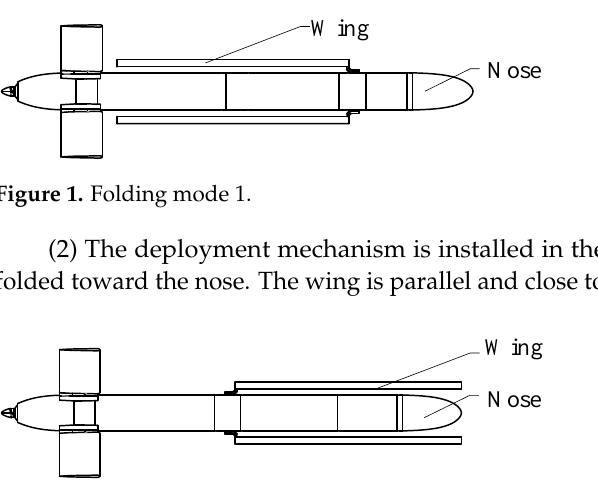
Figure 2. Folding mode 2.